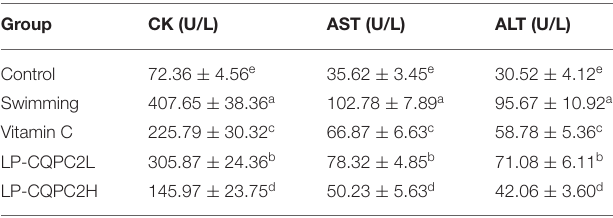
TABLE 3 | Serum CK, AST, and ALT levels of mouse in each group.